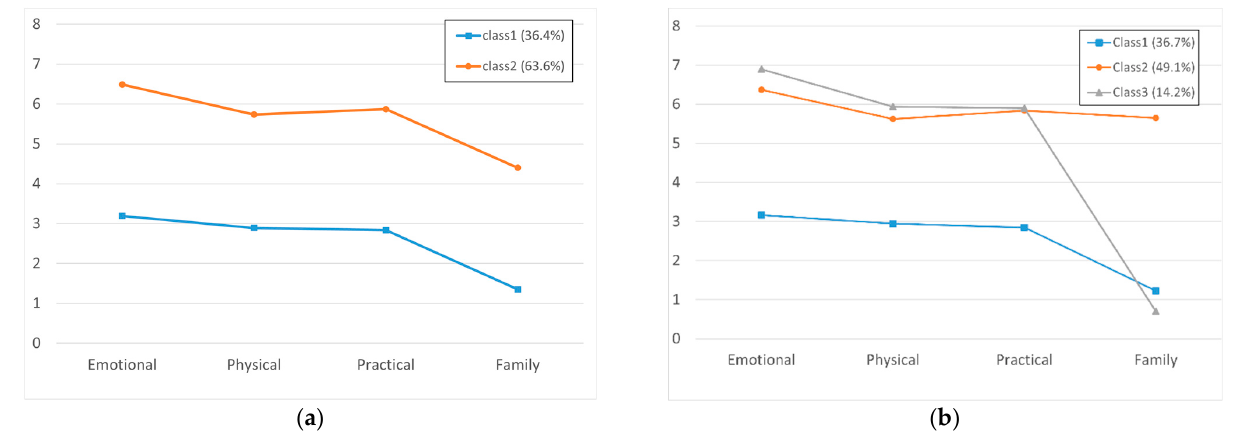
Figure 1. Profile solution: ( a ) 2-profile solution; ( b ) 3-profile solution.